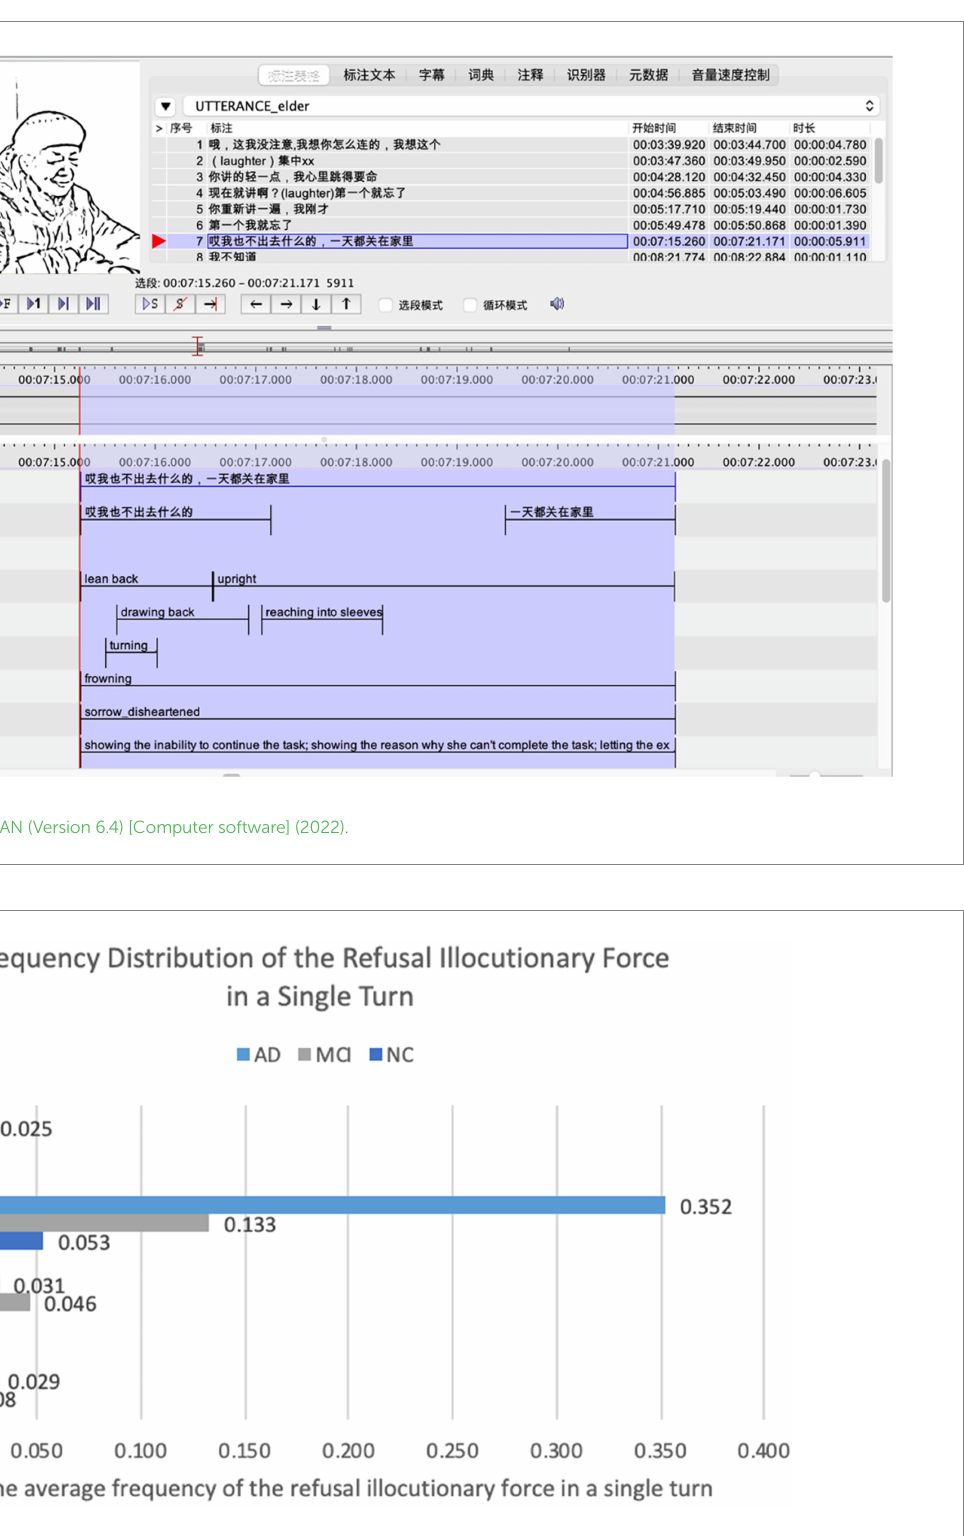
FIGURE 2 Frequency distribution of the RIF in a single